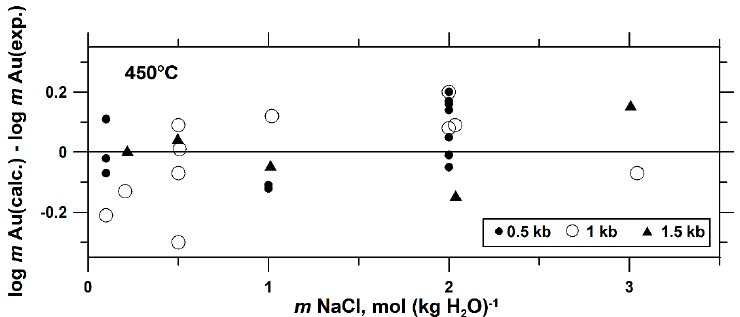
Figure 3. Difference between Au solubilities calculated using Equation (5) and observed in the experiments vs. NaCl molality.